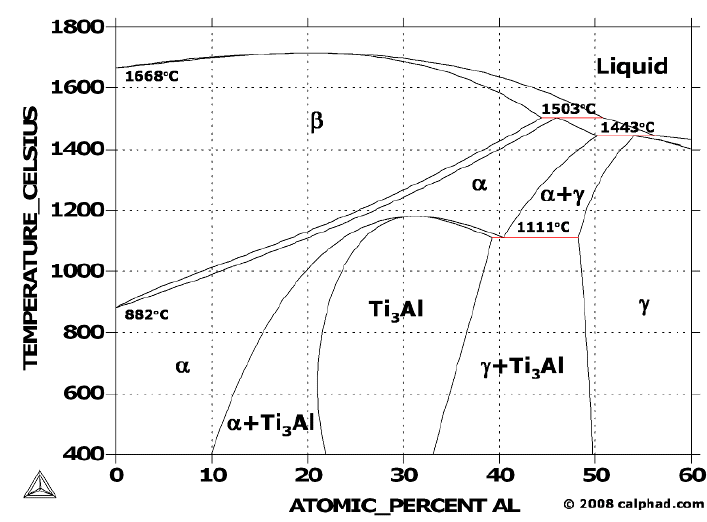
Figure 10. Ti-Al binary phase diagram.